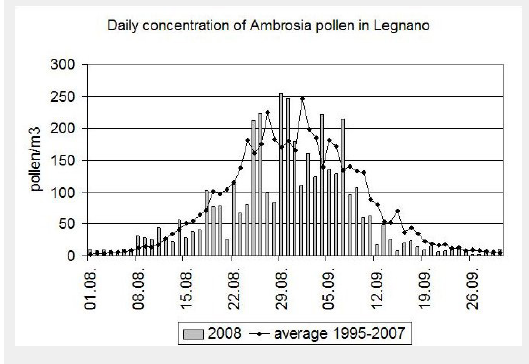
The daily concentration of Ambrosia pollen in Legnano in 2008 and the average daily concentration over the years